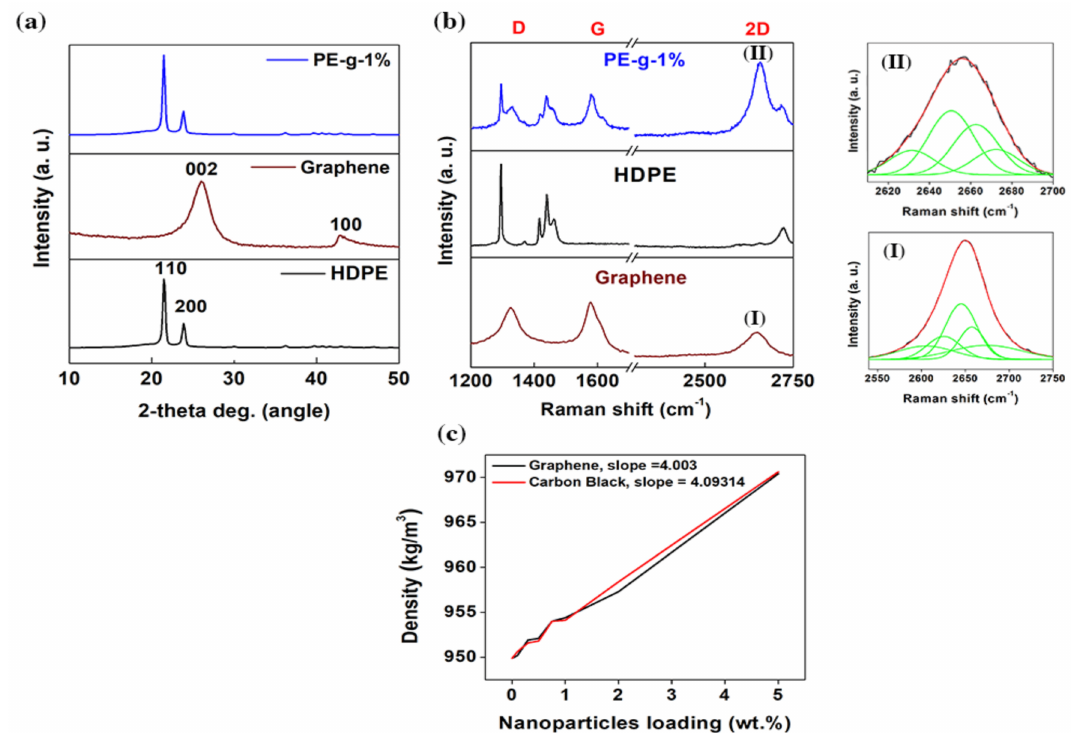
Figure 4. Dispersion and distribution of graphene platelets within the polymer matrix. ( a ) XRD patterns of the neat multimodal-HDPE, graphene powder, and PE-g-1%. ( b ) Overlaid Raman spectrum of the neat multimodal-HDPE, graphene powder, and PE-g-1%. The measured 2D Raman bands with 1.96 eV laser energy of graphene ( I ) and PE-g-1% ( II ) are fitted with four and five Lorentzians, respectively. ( c ) Density measurement of graphene/multimodal-HDPE (PE-g), and carbon black/multimodal-HDPE (PE-CB) nanocomposites as a function of nanofiller loading (0.1, 0.5, 1, 2, and 5